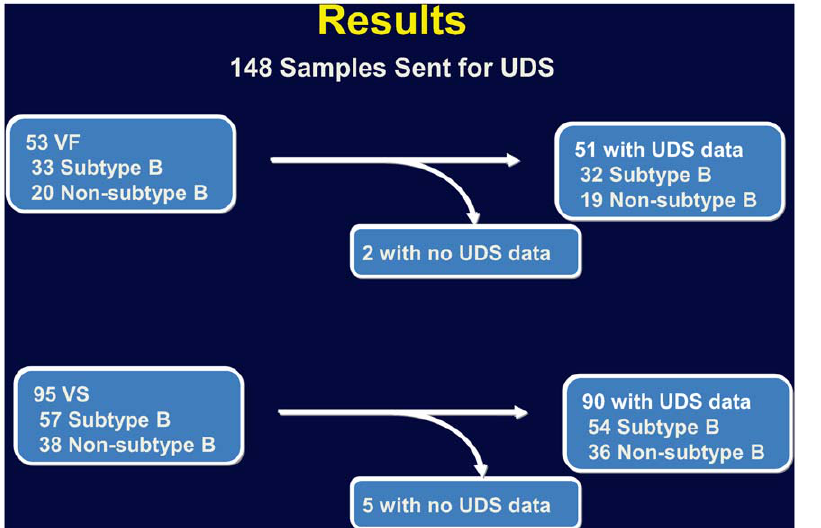
Figure 1. Results of Ultra Deep Sequencing Analysis. 148 samples recovered and sent for UDS: Subtype B (n=90), Non-B (n=58); 53 were VF and 95 were VS. 141 samples had UDS data: Subtype B (n=86), Non-B (n=55) 51 VF and 90 VS. Of the 7 samples without UDS data, 2 had partial UDS data and were not included; 3 samples were exhausted; and 2 had low viral loads and unable to amplify. VF: Virologic Failure, VS: Virologic Success.